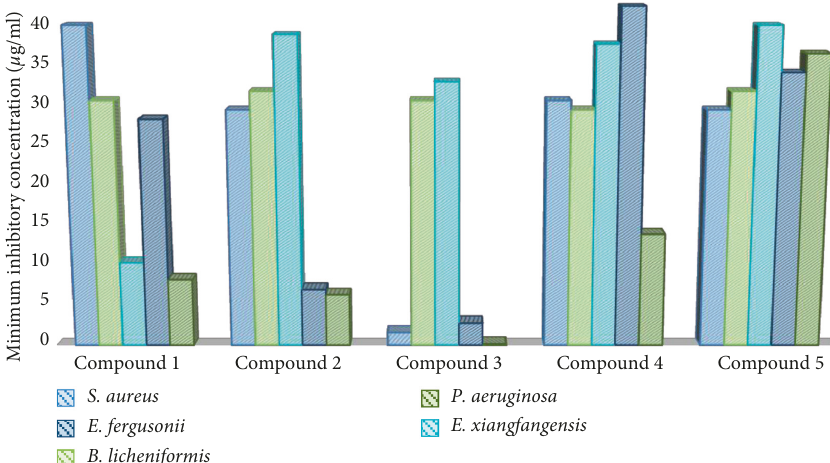
Figure 2: Average MIC values of the five tested compounds against all the test